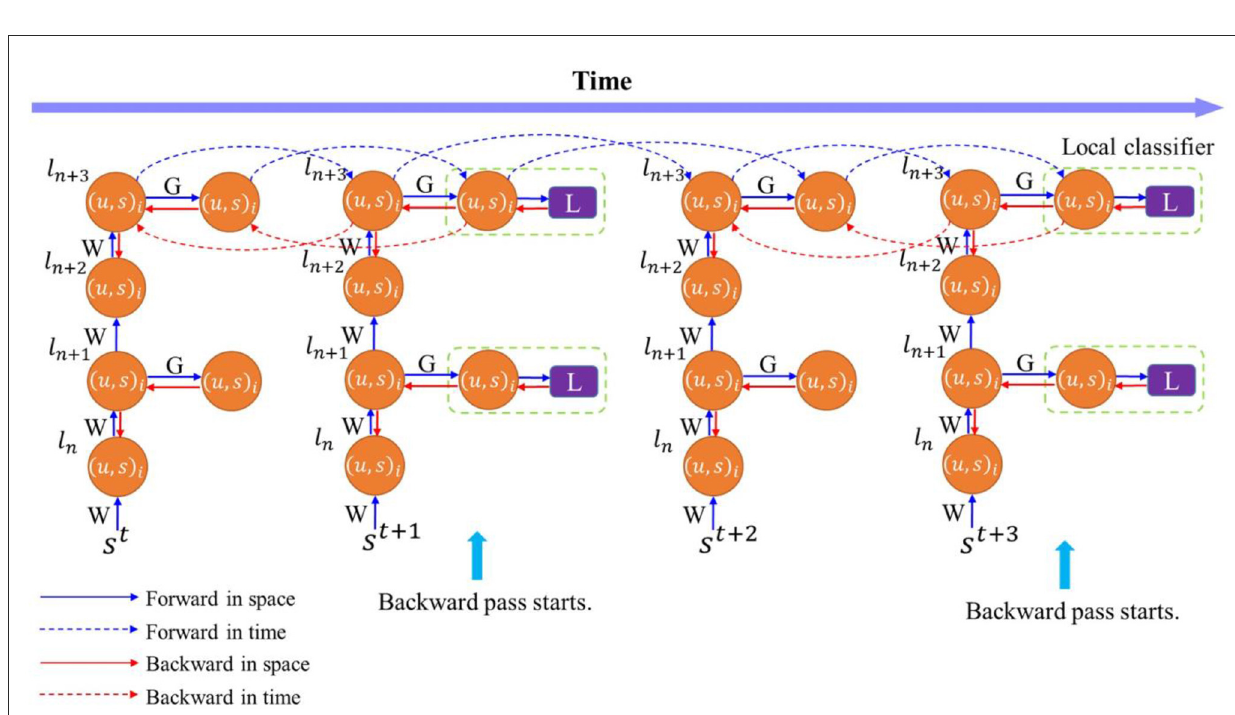
FIGURE2 Training process of an SNN with temporally-truncated local BPTT unfolded in time. In this illustration, the length of the truncation interval and local block are both 2. The forward and backward update flows are indicated by the blue and red arrows, respectively. The update flows in time (dashed arrows) are only depicted for the top layer for clarity. W represents the weights between layers in the main network, and G is the weights between local blocks and classifiers.